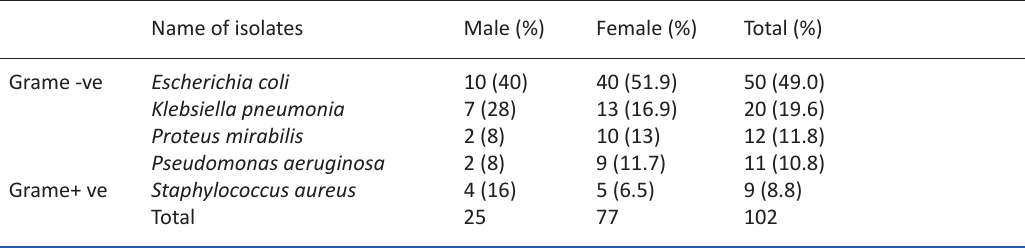
Table 1. Gender wise allocation and occurrence of pathogens producing urinary tract infections (UTIs) in Basra, south Iraq Name of